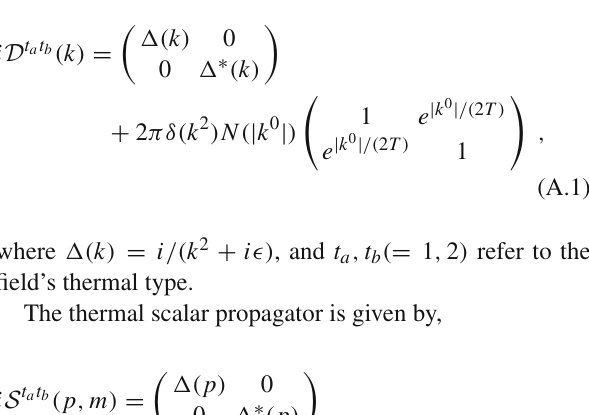
a b Fig. 11 Allowed vertices for scalar–photon